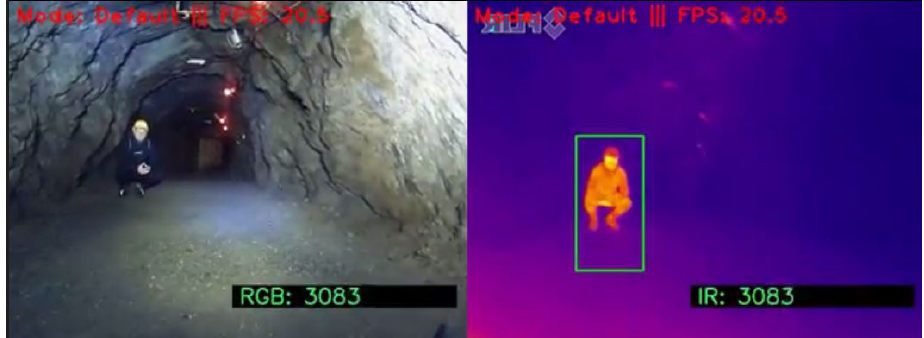
Figure 15. Human in squatting position—no detection in RGB image, correct detection in the IR image with algorithm HOG